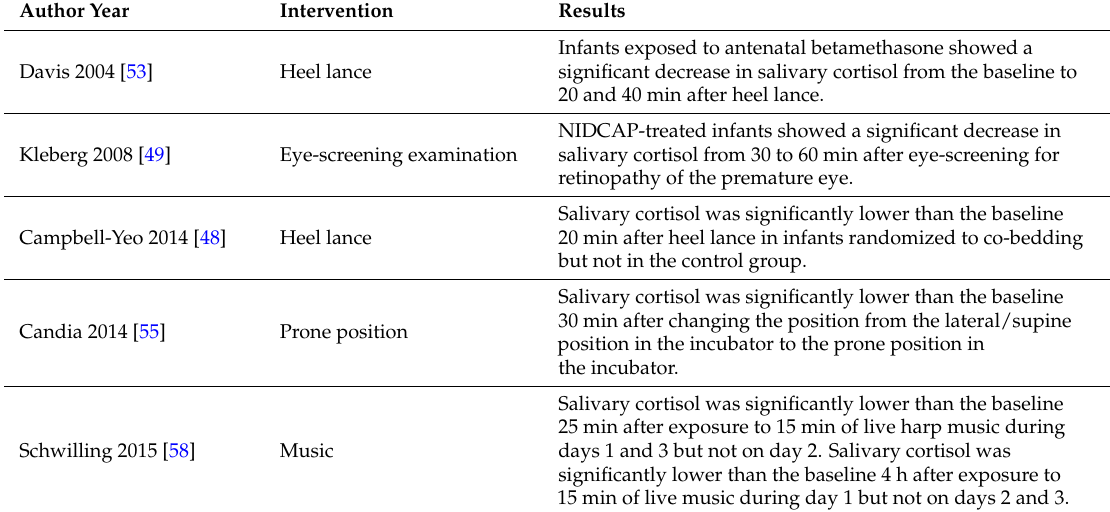
Table 3. Studies reporting a decrease in salivary cortisol levels from the baseline with different interventions ( n =